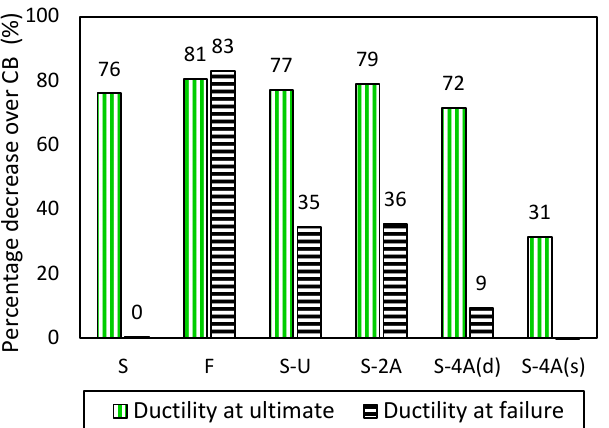
Figure 8. Percentage decrease in the ductility at ultimate and failure states with respect to the control beam.